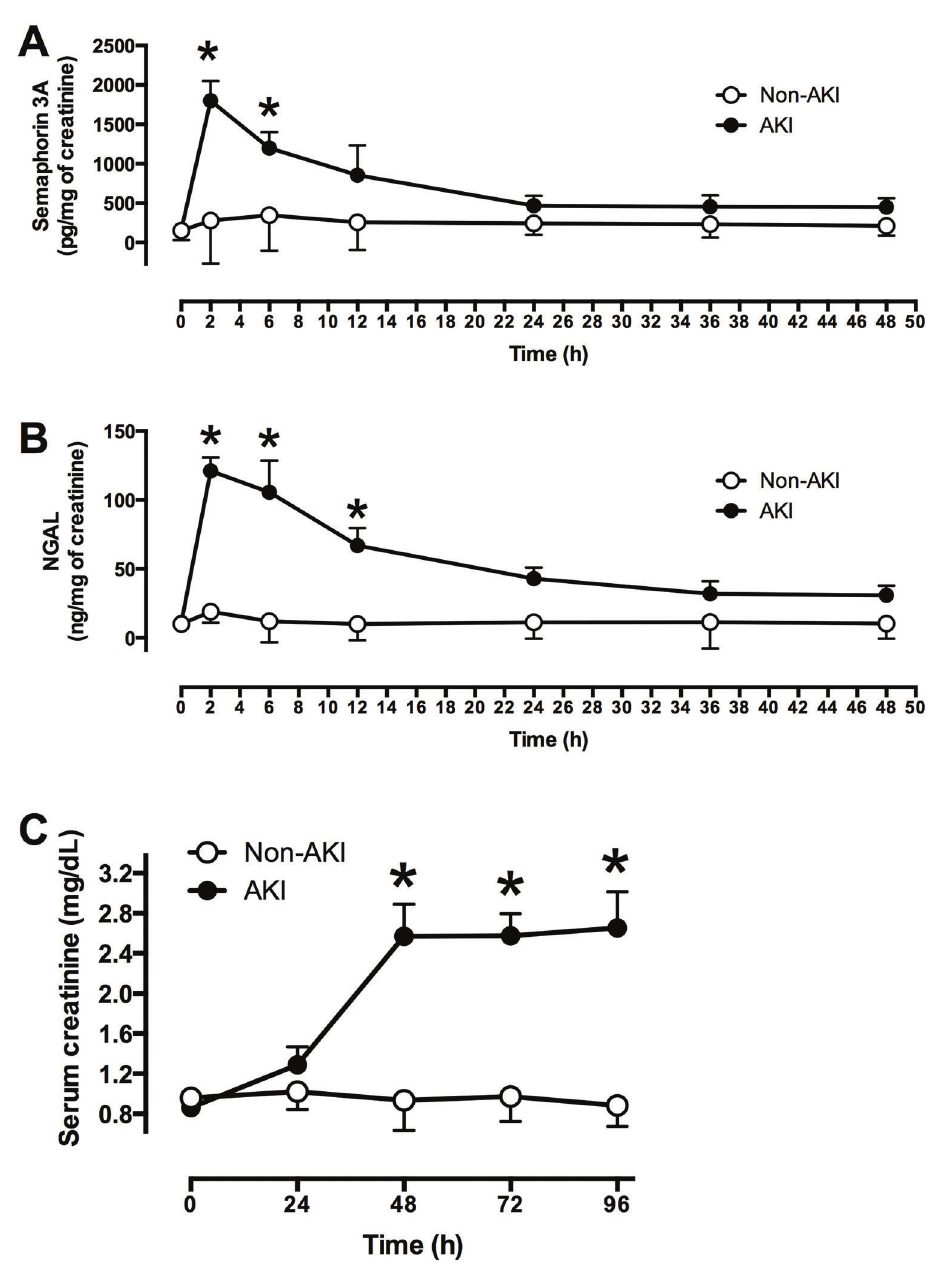
Figure 1. Changes in urinary semaphorin 3A ( A ), urinary neutrophil gelatinase-associated lipocalin (NGAL) ( B ) and serum creatinine concentrations ( C ) at various time points after percutaneous coronary intervention in patients with acute kidney injury (AKI) and without AKI (Non-AKI). Data are reported as means and SD. *P o 0.05 between groups (repeated measures two-way